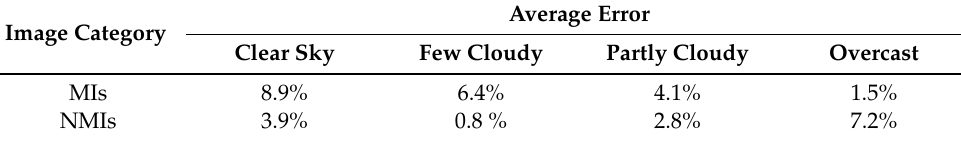
Table 2. Comparison results of current analysis and manually labeled results. The average error is defined as the average of the analysis results minus manually labeled results of multiple images in each